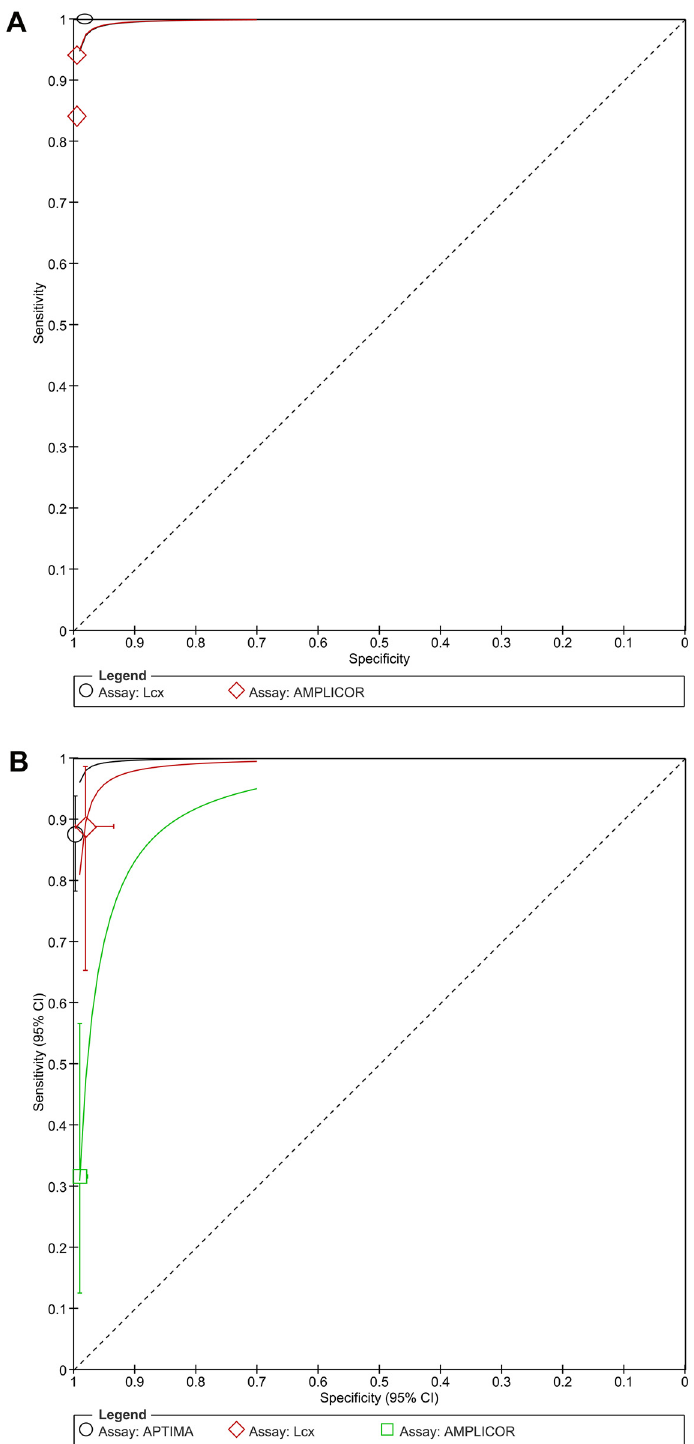
Fig 5. Fixed effects sROC plots of gonorrhea studies comparing self-collected urine to either clinician-collected urethra (left) or cervical (right) samples by PCR assay type. Colored lines represent the sROC curve by assay